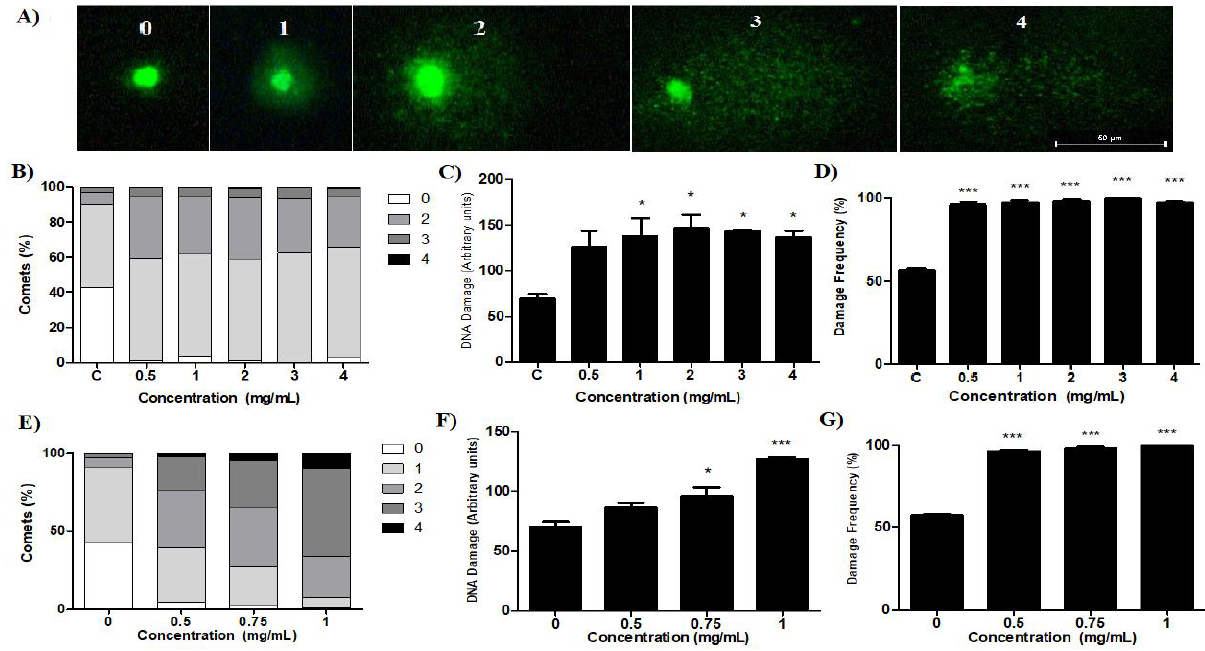
Figure 6. Comet assay images obtained from B. glabrata hemocytes stained with Sybrsafe™, and DNA damage after exposure to different concentrations of saline extract and fraction. Different degrees of damage, where 0 indicates absence and 1 to 4 indicates increasing DNA damage ( A ), damage levels ( B ), index ( C ) and frequency of damage after exposure to saline extract ( D ); damage levels ( E ), index ( F ) and damage frequency after exposure to fraction ( G ). C: negative control. * p < 0.05 and *** p <